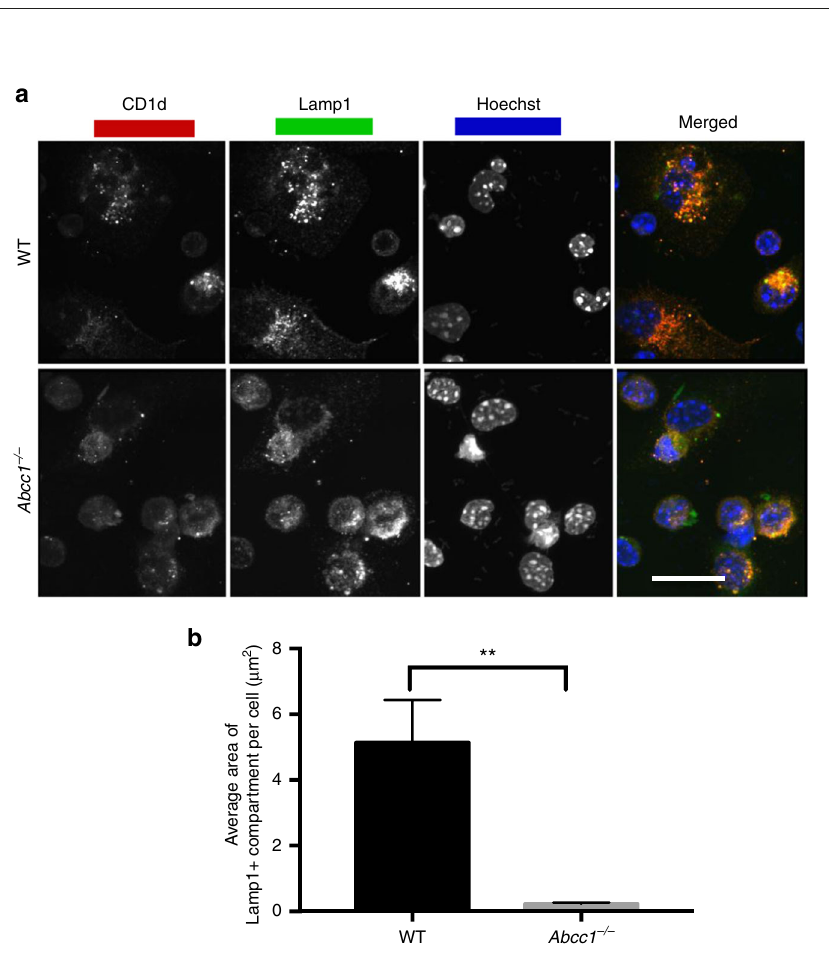
Fig. 9 Reduced CD1d-Lamp1 + vesicles in macrophages from Abcc1 − / − mice. a Peritoneal macrophages were stained with CD1d and Lamp1 antibodies along with Hoechst and images were acquired using confocal microscopy. Representative images from one of two experiments with at least 100 cells per condition analyzed. b Average area of Lamp1 + compartments in WT and Abcc1 − / − mice. Scale bar 20 μ m. Graphs represent mean ± SEM. ** p < 0.01 (one- way ANOVA). See also Supplementary Fig.